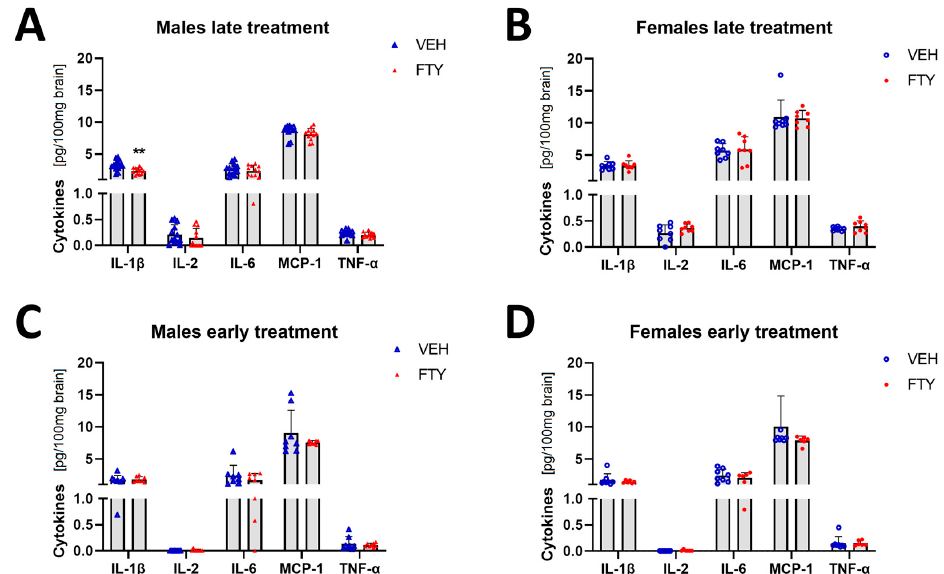
Figure 5. Levels of selected cytokines in brain tissue in late and early treated animals. ( A , B ) Quantification of IL-1 β , IL-1, IL-6, MCP-1, and TNF α in late treated males ( A ) and females ( B ). ( C , D ) Quantification of the cytokines in early treated males ( C ) and females ( D ). Data are presented as mean ± SD; n = 8 except late treatment males (VEH n = 13; FTY n = 12) and early FTY treatment females ( n = 6). Significance was calculated using Student’s t -test, and it is given as **: p ≤ 0.01.